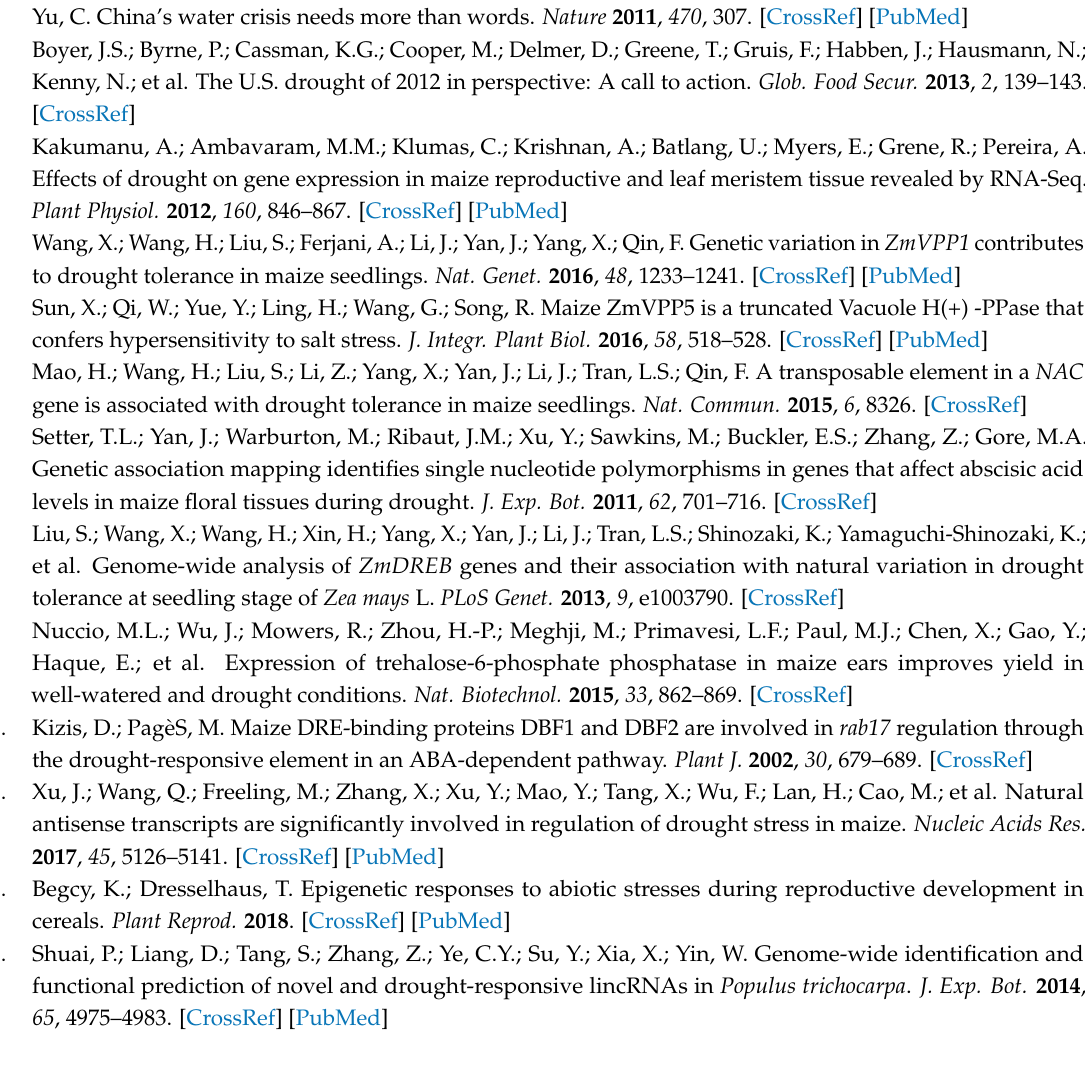
Table S1: The genomic positions of the 3488 high-confidence lncRNAs and their expression levels in all the 94 samples. Table S2: The expression levels of the 132 lncRNAs that respond to drought specifically in ear and showed the most expression changes at R1 stage. Table S3: The 124 lncRNA-mRNA pairs that function in cis -acting ways. Table S4: The 539 lncRNA-mRNA pairs that function in trans -acting ways. Table S5: List of maize classical genes that are targeted by lncRNAs. Table S6: Primers used for real-time quantitative reverse transcriptase-PCR